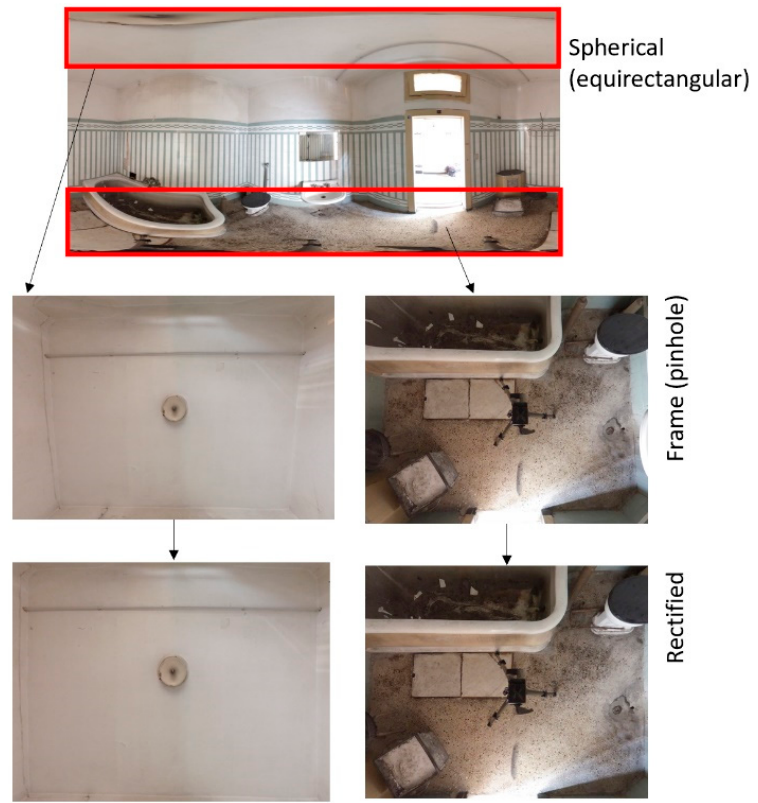
Figure 6. The rectification procedure applied to floors and ceilings. Such results coupled with the previous ones reported in Figure 4 provide a set of mapped deterioration for the entire room.